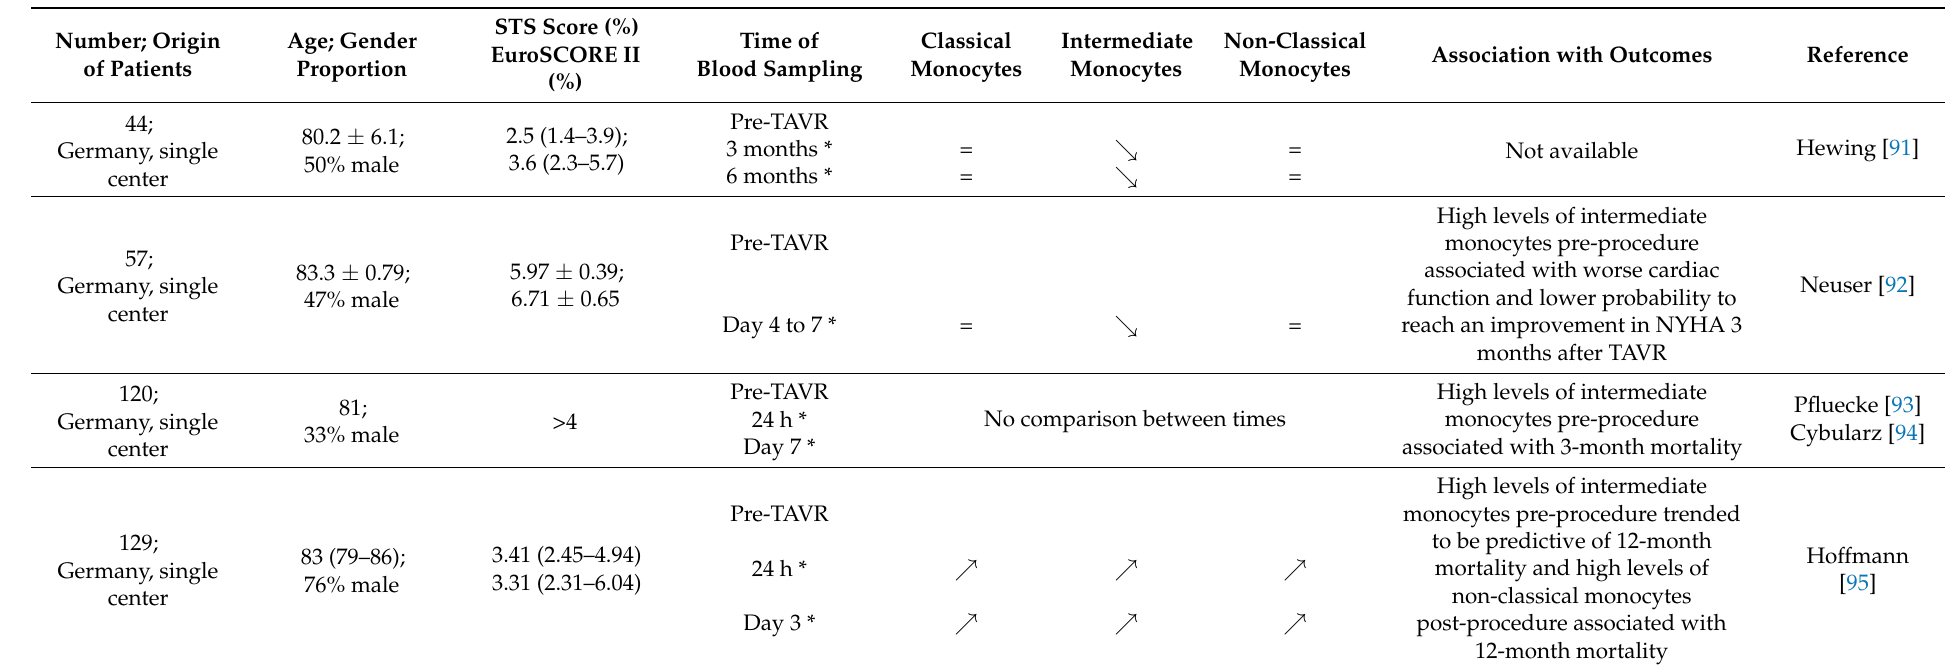
Table 2. Evolution of the circulating monocyte subsets (absolute values, compared to pre-transcatheter aortic valve replacement (TAVR)) in patients with aortic valve stenosis underwent TAVR. Age, Society of Thoracic Surgeons (STS) score and European system for cardiac operative risk evaluation (EuroSCORE II) are presented as mean ± standard deviation or median (interquartile ranges) according to available data. *: post-TAVR; =: stable; (cid:37) : increase; (cid:38) : decrease. Abbreviation: New York Heart Association